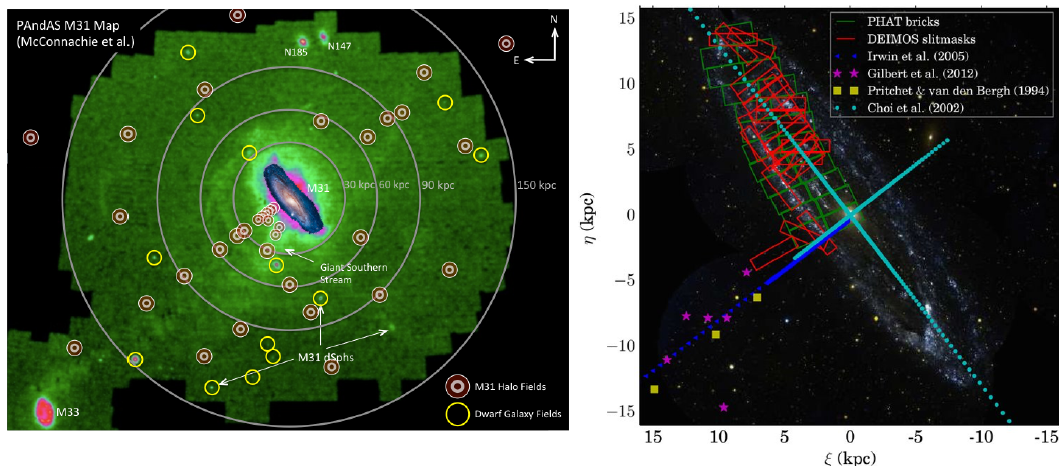
Figure 2. The locations of M31 halo and disk spectroscopic fields in the SPLASH survey. ( Left ) Fields targeting M31’s halo, tidal debris features, and dwarf galaxies, superimposed on a stellar density map created from the Pan-Andromeda Archaeological Survey (PAndAS) observations [23] (Figure 2 of Gilbert et al. [9]). ( Right ) Fields targeting M31’s disk; many of these spectroscopic masks